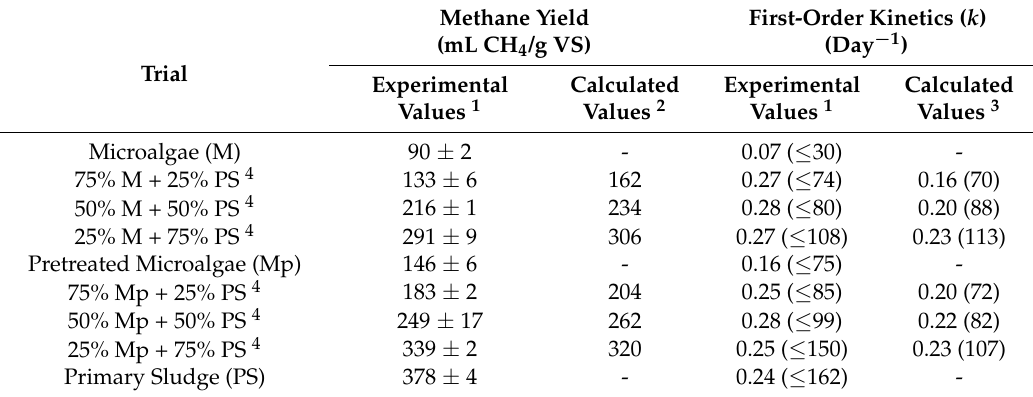
Table 2. Ultimate methane yield (mean values ± standard deviation) and first-order kinetics constant ( k ) (error variance (s 2 ) represented in brackets) obtained in the biochemical methane potential (BMP) test. Methane Yield First-Order Kinetics ( k ) (mL CH 4 /g VS) (Day − 1 ) Trial Experimental Calculated Experimental Calculated Values 1 Values 2 Values 1 Values 3 Microalgae (M) 90 ± 2 - 0.07 ( ≤ 30) 75% M + 25% PS 4 0.23 (113) Pretreated Microalgae (Mp) 146 ± 6 - 0.16 ( ≤ 75) 75% Mp + 25% PS 4 183 ± 2